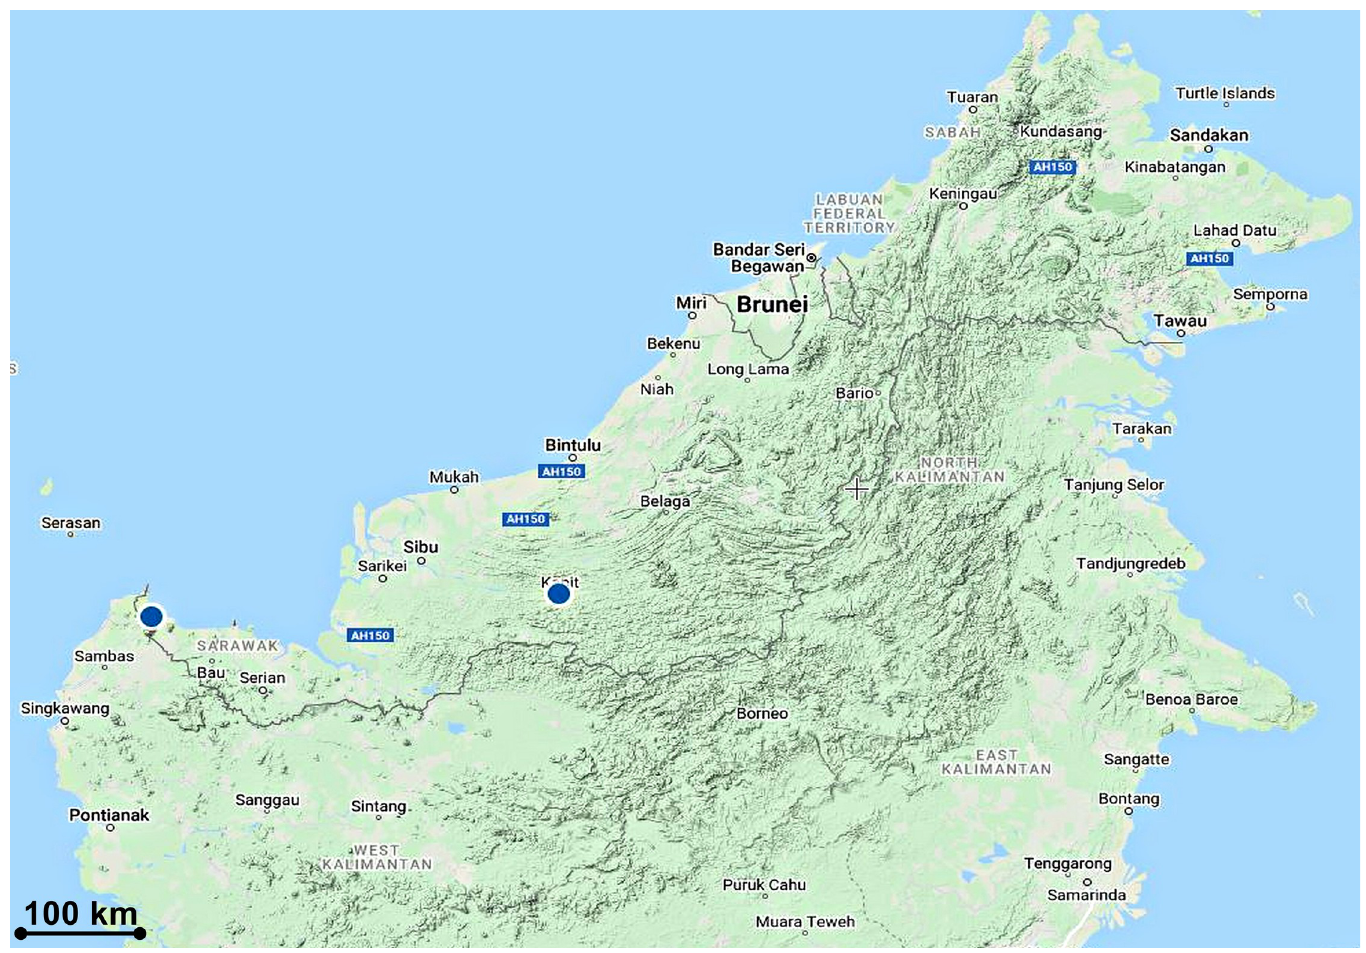
Fig 11. Distribution of Bryobium cordiferum subsp. borneense